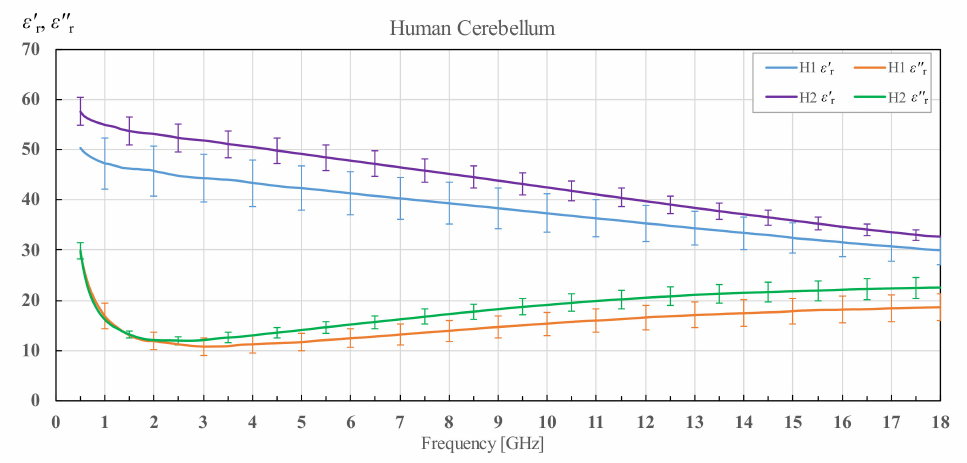
Figure 6. Average permittivity of human grey matter with standard deviation and Cole–Cole fit, shown in comparison with the data from IT’IS database [21] and Schmid et al. [28].